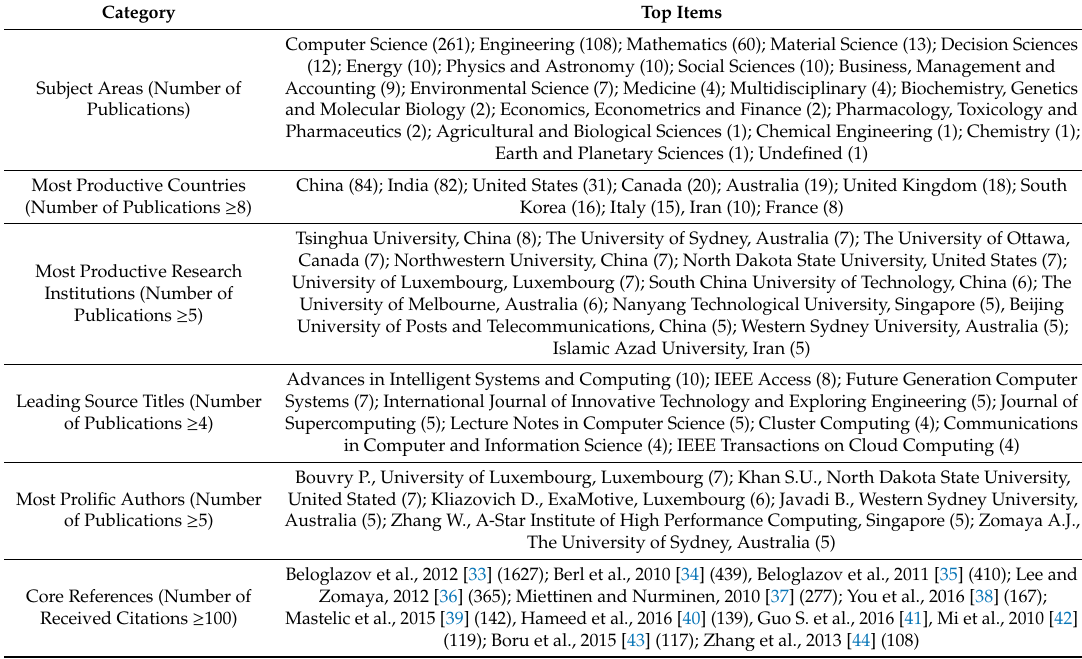
Table 4. General publication profiling of research on cloud computing energy e ffi